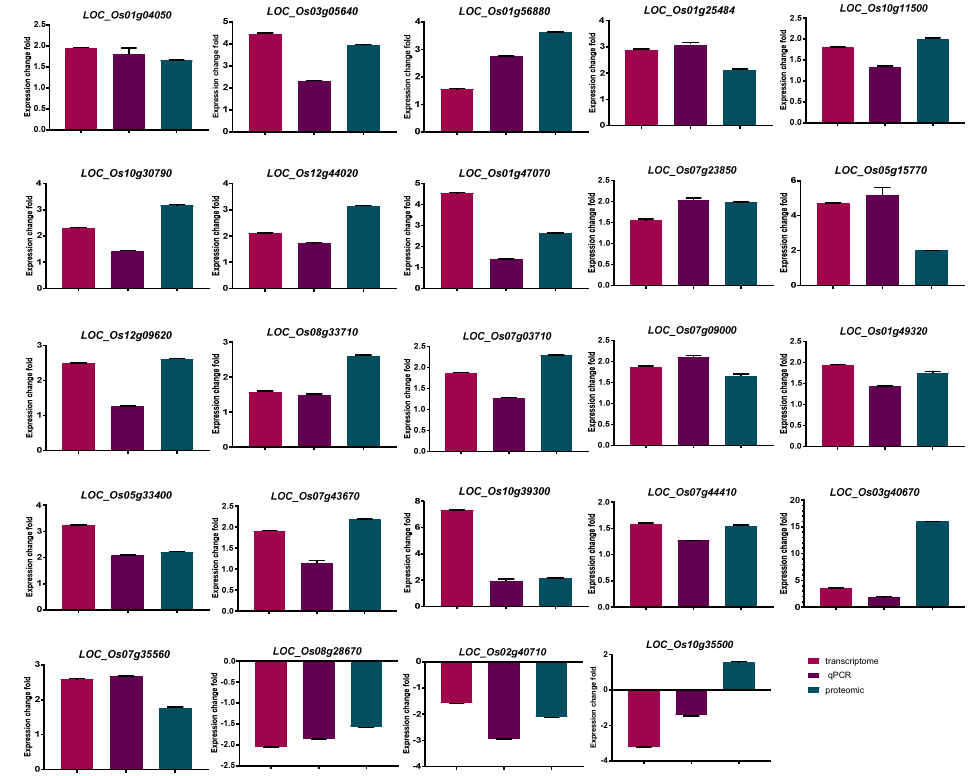
Figure 3. Quantitative real-time PCR analysis of 24 significant differential expression proteins with fold changes both in transcriptome and proteomics levels larger than 1.5 in DXWR. Bars mean SD. Expression change fold refers to the change of the treatment group compared with the control group.